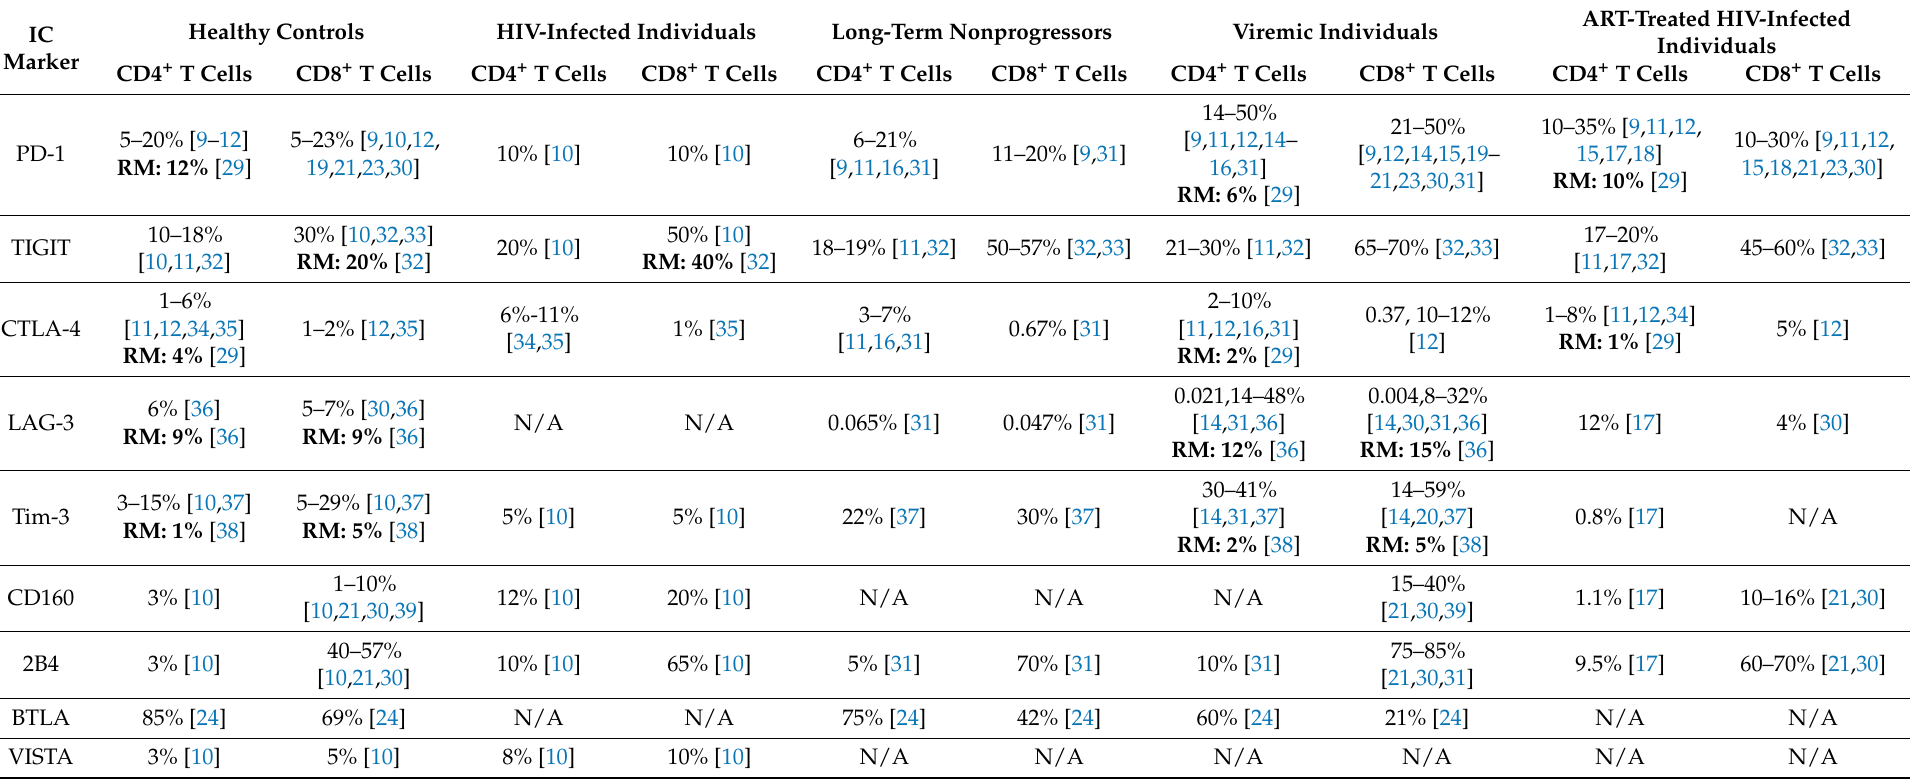
Table 1. Expression profile of immune checkpoint markers on T cells from HIV/SIV-infected